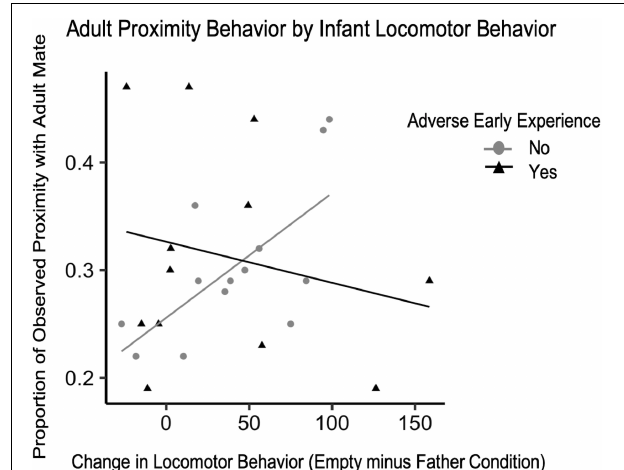
FIGURE 6 | Novelty response task participation ( N = 11) by infant behavior, specifically, time spent touching the grate. Interaction plot for the effects of test condition on the relationship between infant grate touching behavior and adult task participation during difficult novelty response task trials.